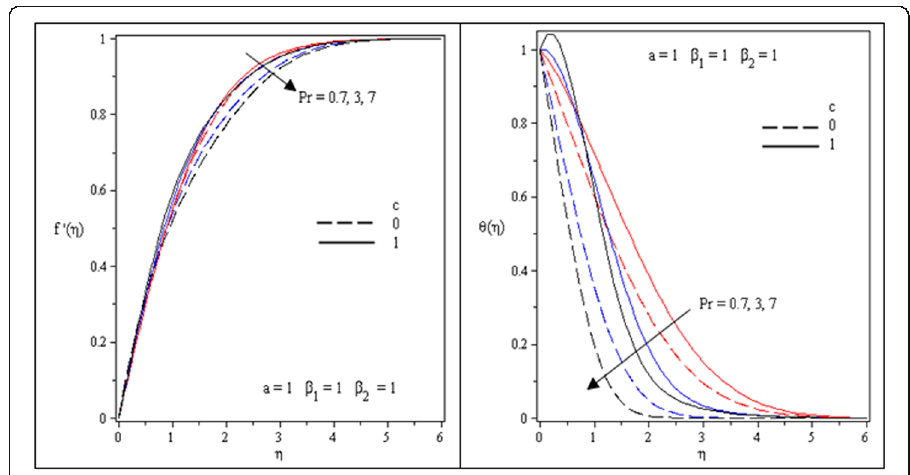
Fig. 6 Velocity and temperature profiles for the Prandtl number with and without